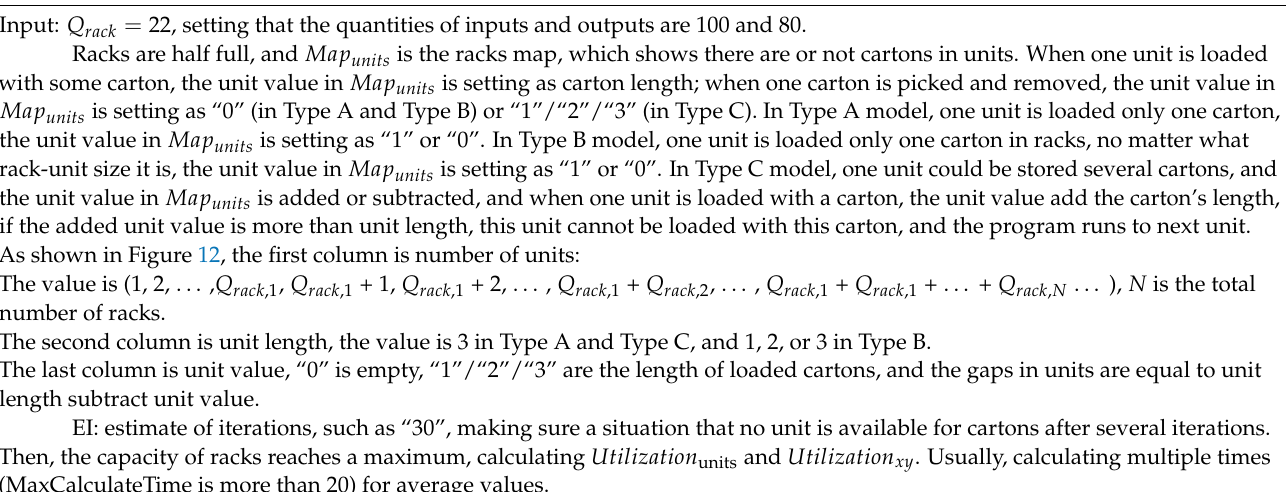
Algorithm 2. The utilization of Type A-FF strategy using